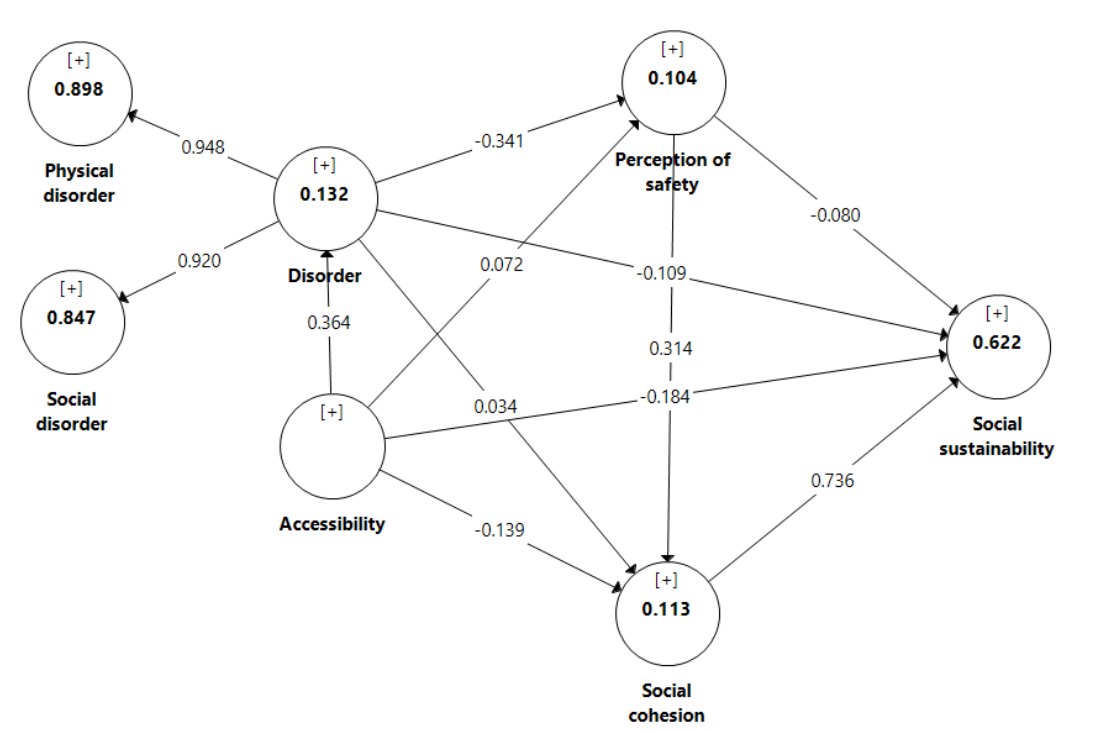
Table 5. Hypothesis testing (indirect effects).